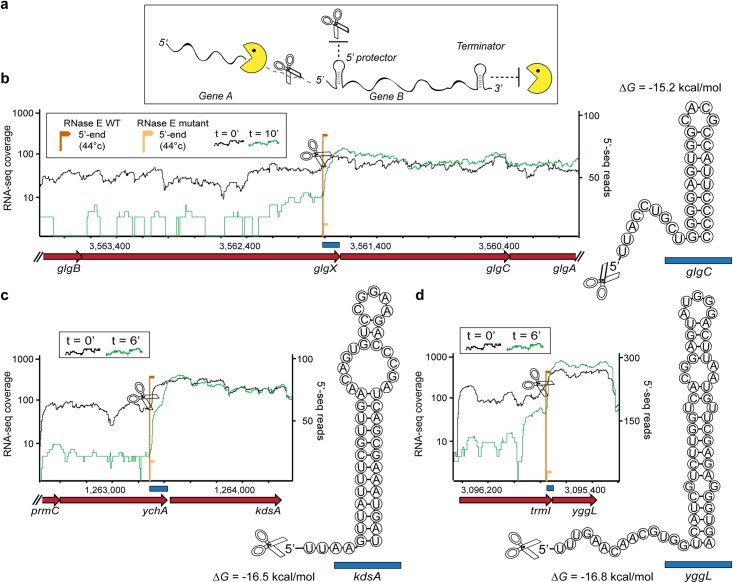
RNase E cleavage and protective 5’-end structures correlate with differential decay.(A), A model for differential decay in operons in which the middle or 3’-most gene is preferentially stabilized, as described for papBA [12]. Scissors and Pac-Man represent endonucleases and 3’-5’ exonucleases, respectively. (B-D), Differential decay in three representative E. coli operons, depicted by normalized RNA-seq coverage in steady state (black, t = 0) or an additional time points (green) following rifampicin treatment. RNA-seq coverage was normalized by the number of uniquely mapped reads in each library. The position and number of reads supporting RNase E cleavage sites in the WT strain or in the RNase E mutant are shown as dark and light orange arrows, respectively. The height of the arrows represents the total number of supporting 5’ end reads across all three replicates, normalized by the number of uniquely mapped reads in each experiment. The predicted structure and stability of the RNA sequence present immediately downstream of the RNase E cleavage site end is shown next to each gene, with blue rectangles specifying the position of the structure in the genome. The 5’ cleavage position is marked by a scissors cartoon.